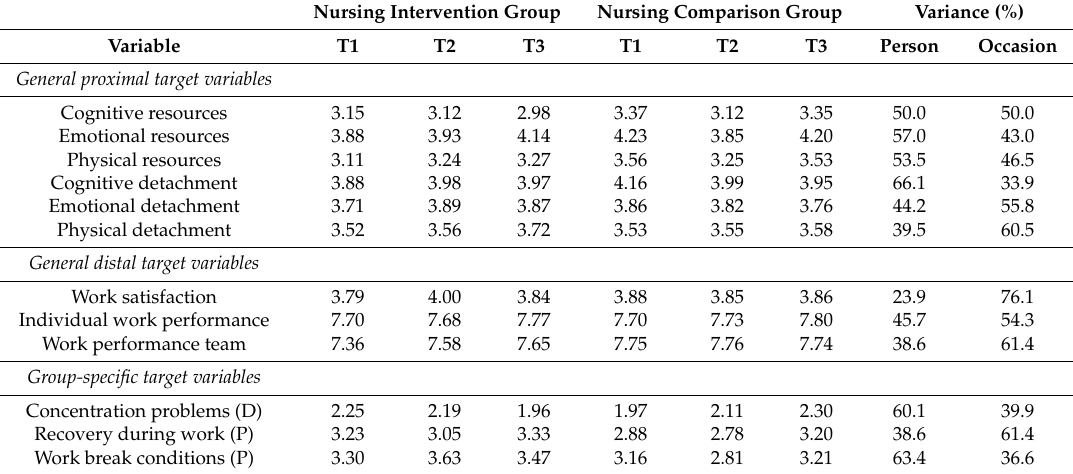
Table 3. Group means and variance components of the target variables for the intervention group and the comparison group in the nursing department ( N = 60 at Time 1).